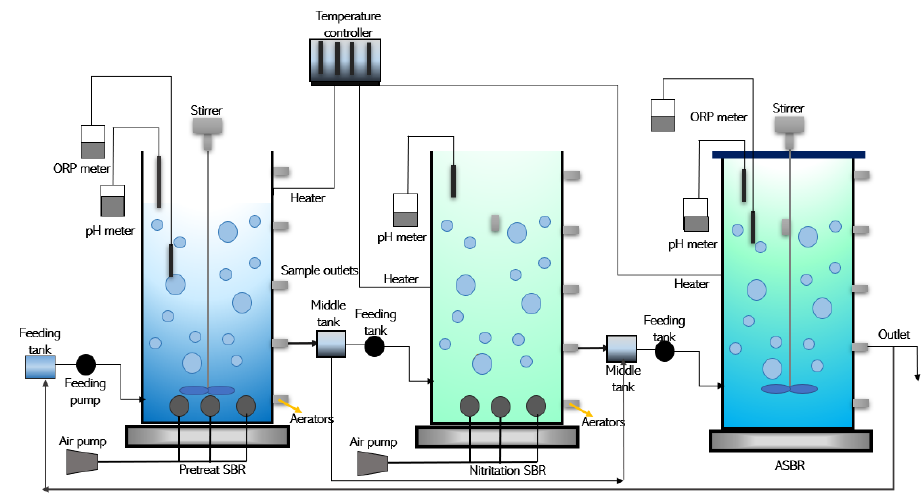
Figure 1. Stages of an operation cycle of an SBR reactor.